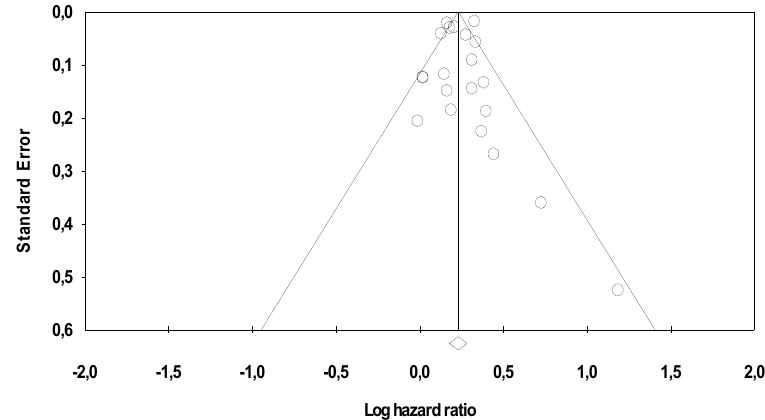
Figure 4. Funnel plot of the relationship between the log hazard ratio (HR) and standard error of the log HR for overall survival (OS) in colorectal cancer studies. The degree of asymmetry was not statistically significant according to the Egger method ( p = 0.47). We used the trim and fill approach to adjust our estimate of effect size for potential asymmetry. The imputed estimate (HR =1.25; 95% CI, 1.18–1.32) was similar to that in the main analysis, indicating that the results are unlikely to be explained by publication bias.